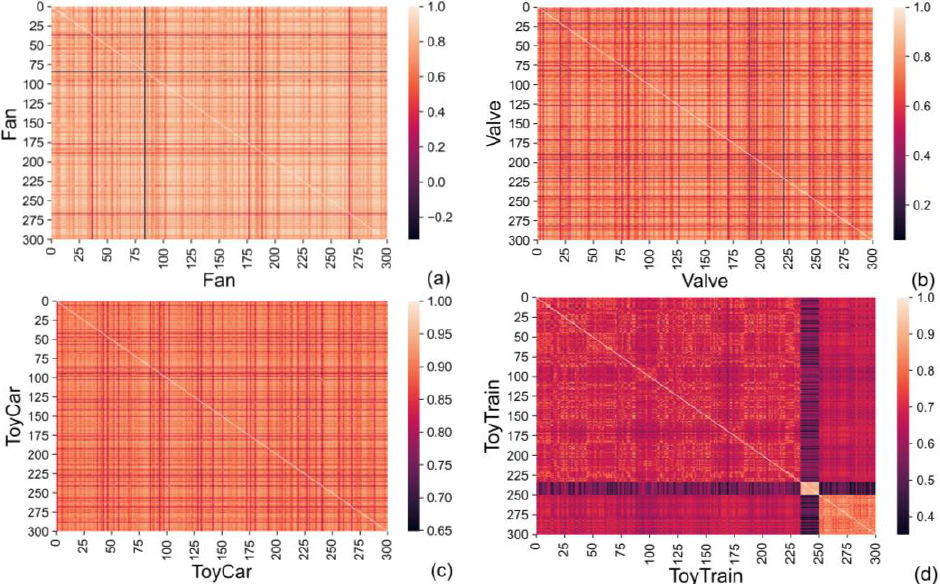
Figure 7. Intraclass PCC similarity values in the form of heat map for the extracted dataset: ( a ) fan, ( b ) valve, ( c ) toy-car, and ( d ) toy-train (ranges of values are given in the provided color bars, and they are not the same for presented heat maps).